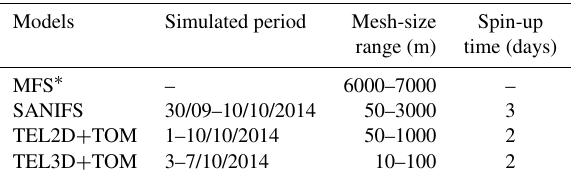
Table 1. Setup of the models used in the present multiple- nesting approach: simulated period, mesh-size and spin-up time for MFS (Fig. 1a), SANIFS (Fig. 1b), TEL2D + TOM (Fig. 1c) and TEL3D + TOM (Fig. 1d)